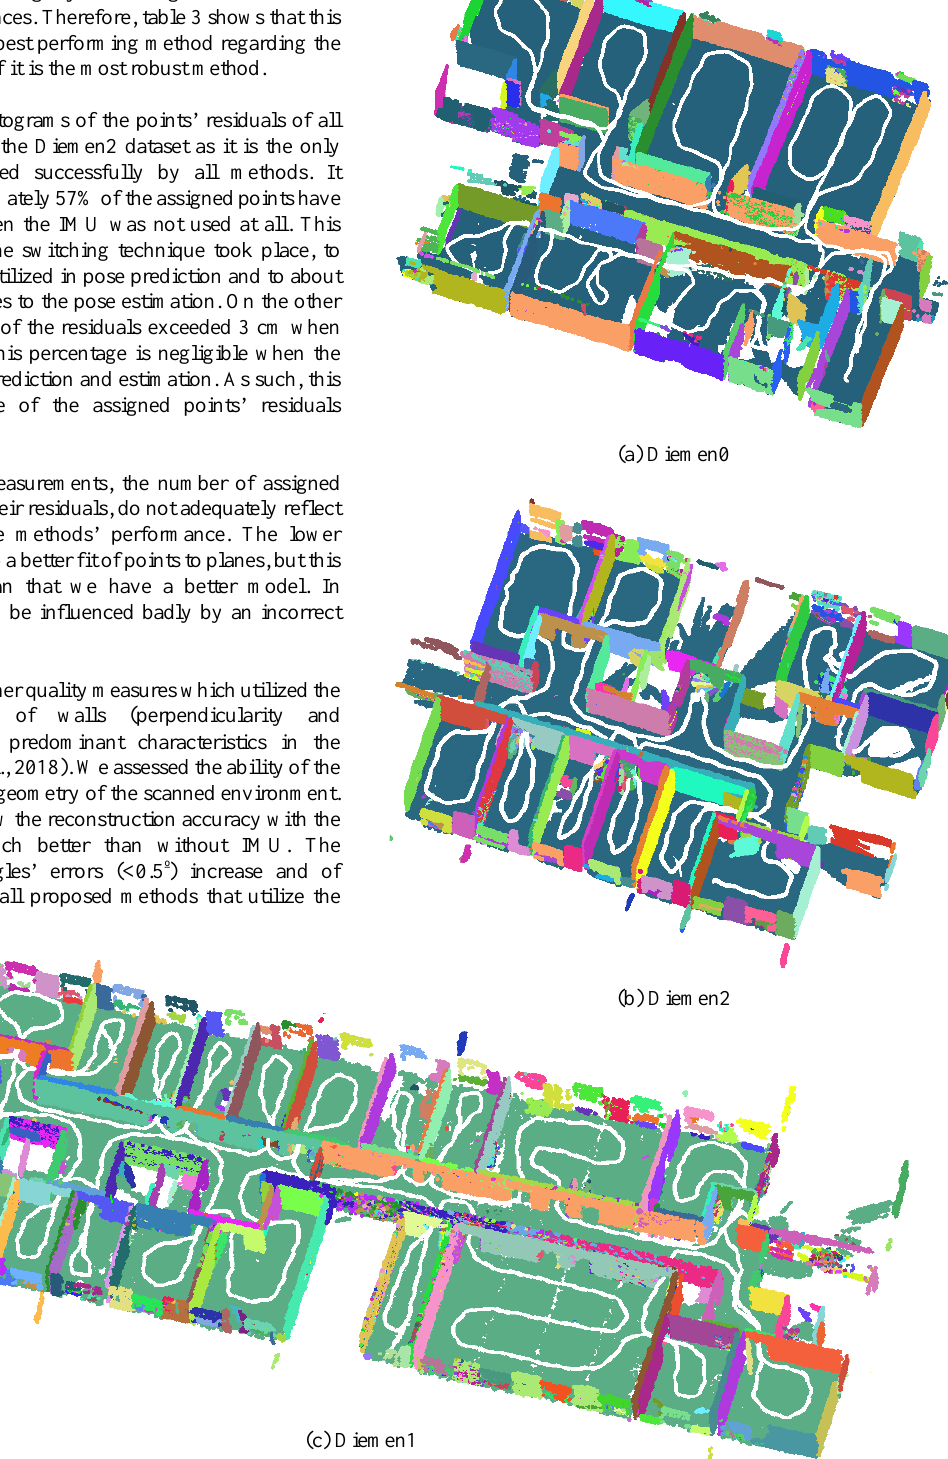
Figure 4. The generated point cloud of the test areas with colours show plane association and trajectory followed (white). For visualization purposes, the points that are not associated to a plane and the points on the ceiling are removed from the point clouds.